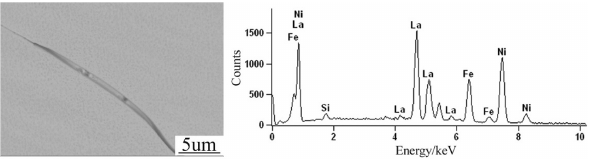
Figure 12: Morphology and energy spectrum analysis of intermetallic compounds at grain